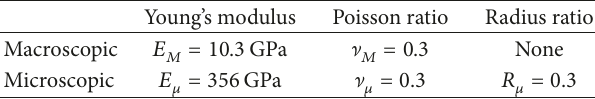
Table 2: Macroscopic and microscopic elastic